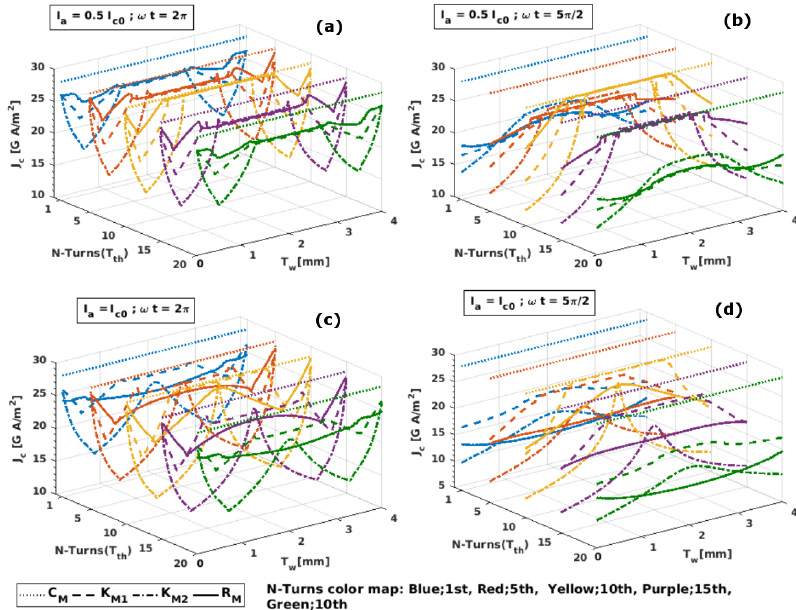
Figure 2. Critical current distribution across the 4-mm-width ( T w ) of the 2G-HTS tape measured at the surface of the 1st, 5th, 10th, 15th, and 20th turn ( T th ) of the modelled coil (Figure 1), under the different material law conditions in Table 1. In this figure we show ( a ) the results for an applied current of amplitude I a = 0.5 I c 0 at the self-field condition ω t = 2 π and ( b ) the peak transport current condition at ω t = 5 π /2. Likewise, ( c ) shows the results for an applied current of amplitude equal to the threshold value of the critical current density I c 0 at ω t = 2 π and ( d ) at ω t = 5 π /2.